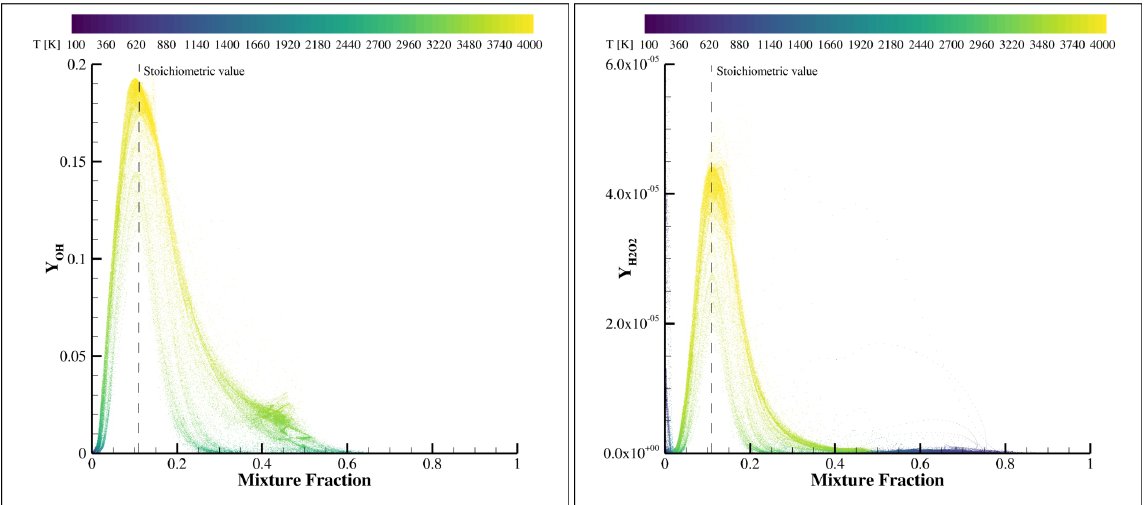
Figure 13. Instantaneous scatter plots of OH and H 2 O 2 mass fractions versus the mixture fraction and parameterised with temperature; the stoichiometric mixture fraction Z = 0.11 is marked as a dashed